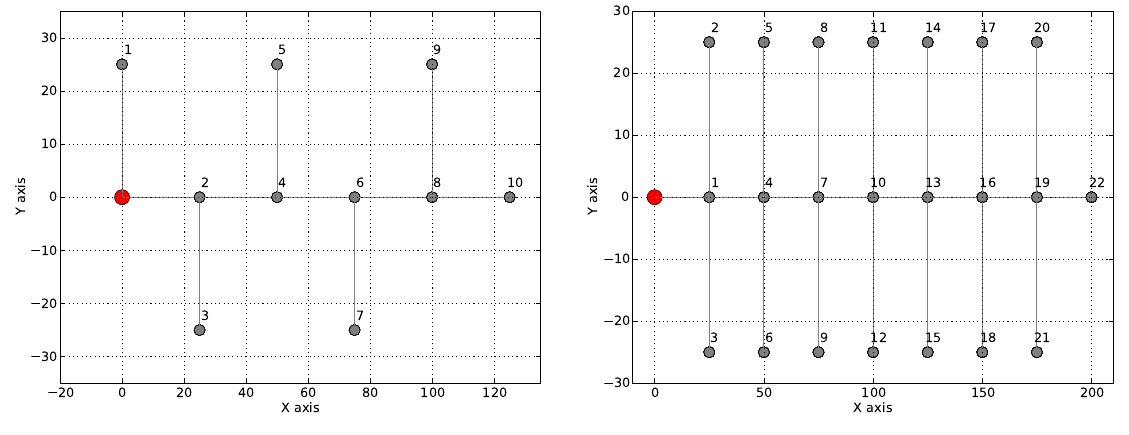
Figure 6. Deployments of 10- and 22-nodes tree